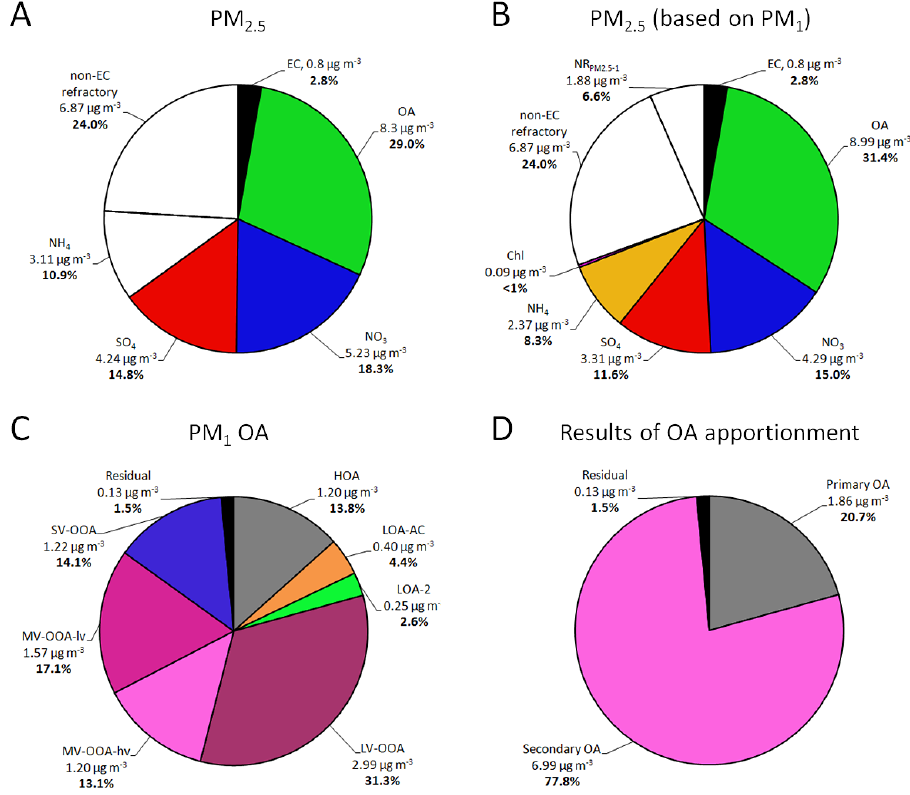
Fig. 13. Average composition of PM 2 . 5 (a–b) and NR-PM 1 OA (c–d) throughout the duration of SOAR-1. (a) shows the average PM 2 . 5 composition based on PM 2 . 5 measurements while (b) shows the same based on NR-PM 1 measurements. Note that colorless sections (e.g., non-EC refractory material) represent estimated as opposed to measured concentrations. (c) and (d) show the average composition of NR-PM 1 OA and the contribution of POA (composed from the combined HOA, LOA-AC, and LOA-2 components) and SOA (summed contribution of OOA components) to OA during the same period (see text for